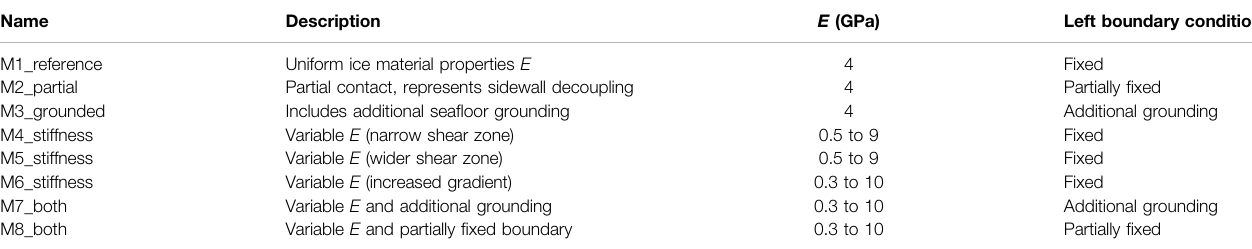
TABLE 1 | Description of each model